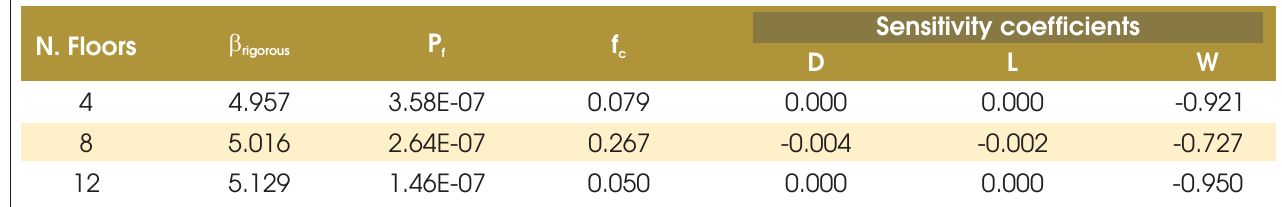
Table 8 – Results for 50-year extreme live load combined with annual maximum wind load